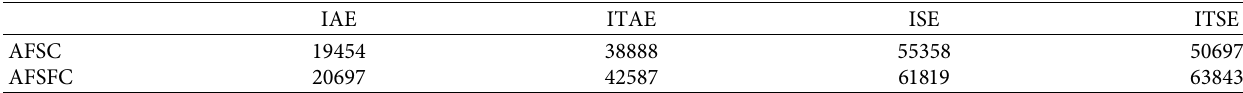
Figure 9: Simulation results of control inputs τ Table 1: Performance comparisons (fault-free